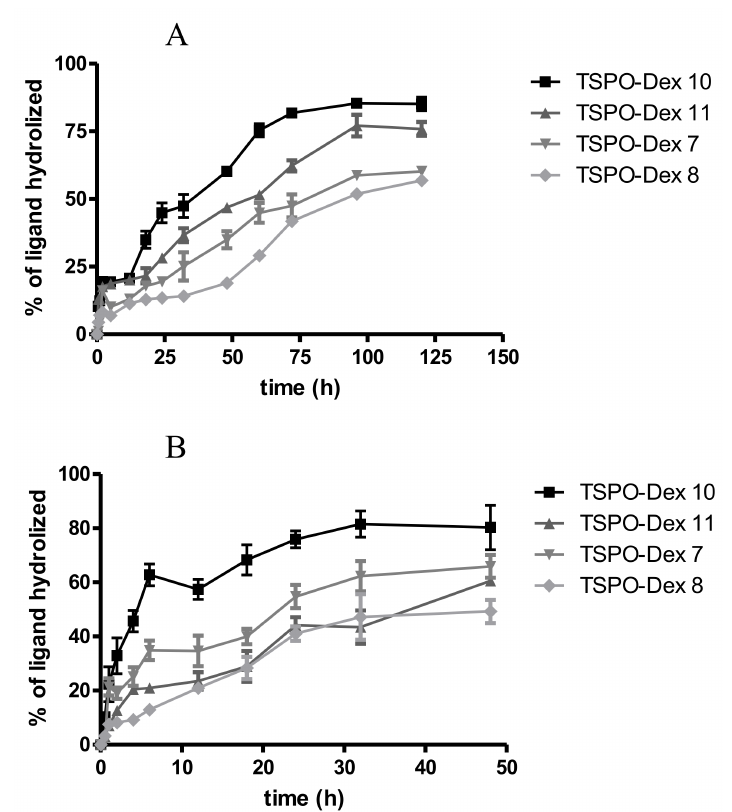
Figure 7. Hydrolysis profile of TSPO-DEX conjugates in ( A ) phosphate buffer (pH 7.4) at 37 ± 0.2 ◦ C, and ( B ) diluted human serum at 37 ± 0.2 ◦